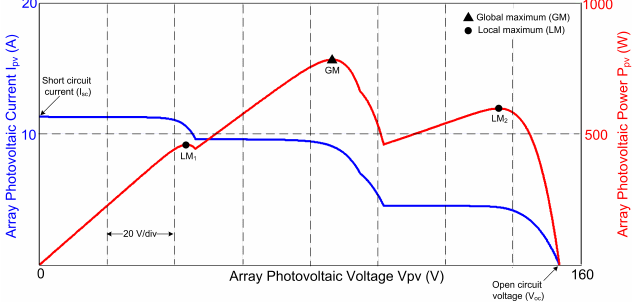
Figure 1. Characteristic curve of an arbitrary PV array under partial shade